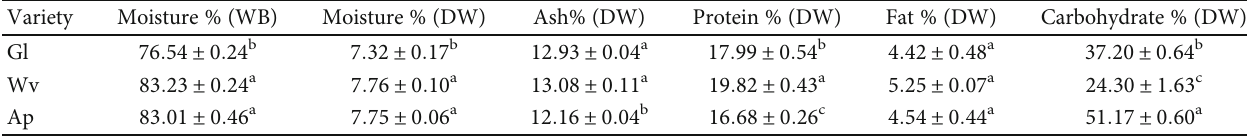
Values are presented as mean ± SD , n = 3 . Values in the same column having the same superscript letters are not signi fi cantly di ff erent ( p > 0 : 05 ). Scienti fi c names of leafy vegetable have been abbreviated as follows: Gl: Gymnema lactiferum ; Wv: Wattakaka volubilis ; Ap: Argyreia populifolia